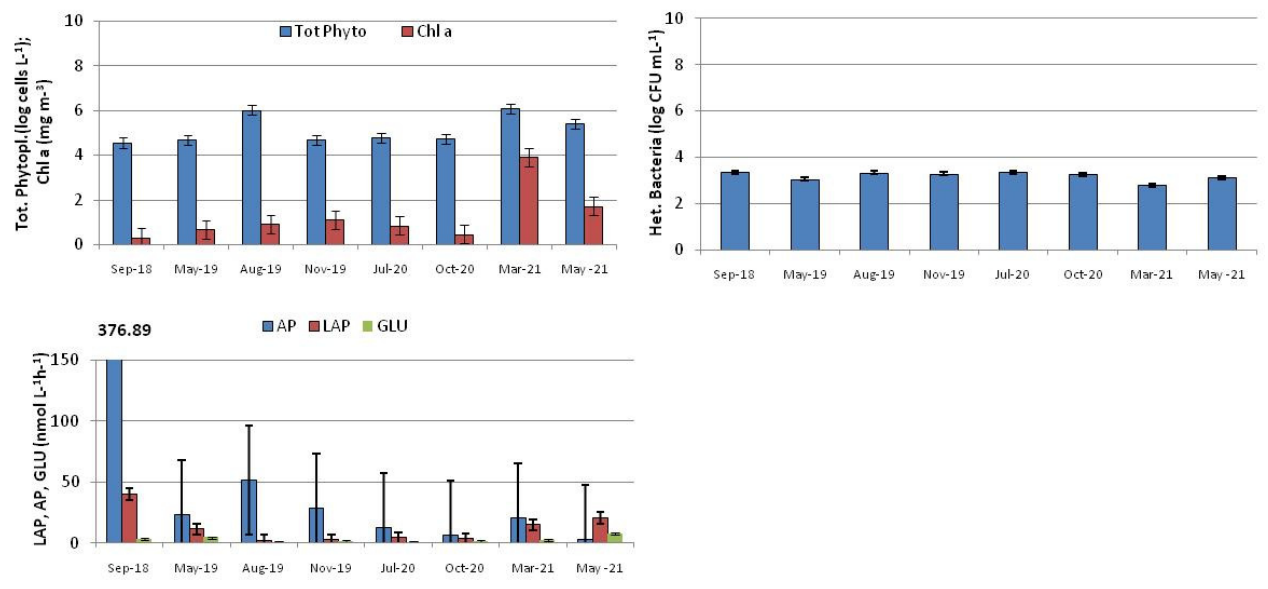
Figure 4. Seasonal trends of autotrophic abundance and biomass (as Chl a content) and heterotrophic bacterial abundance, together with microbial activity rates, observed at the freshwater-affected station (FAS, Station 2).